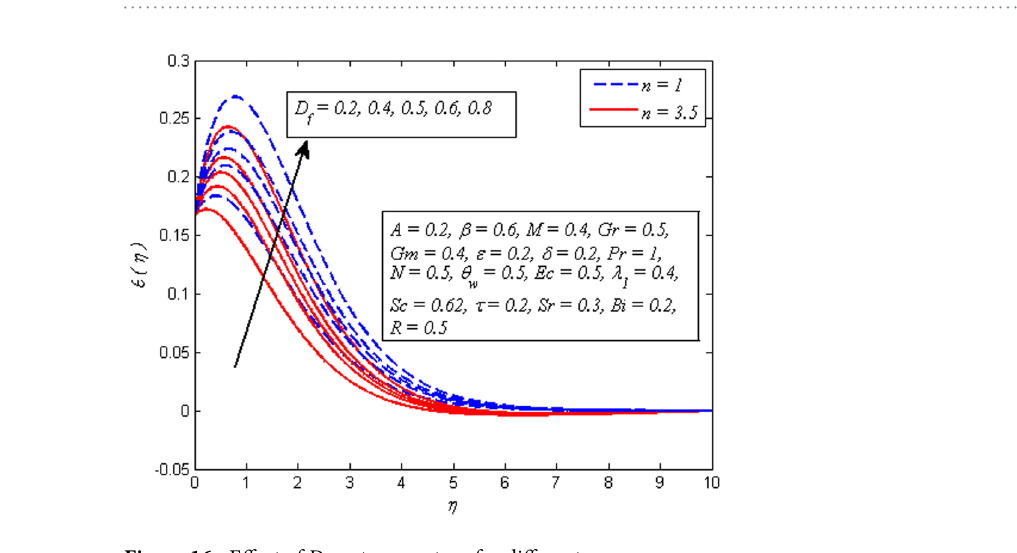
on temperature for different M . 1